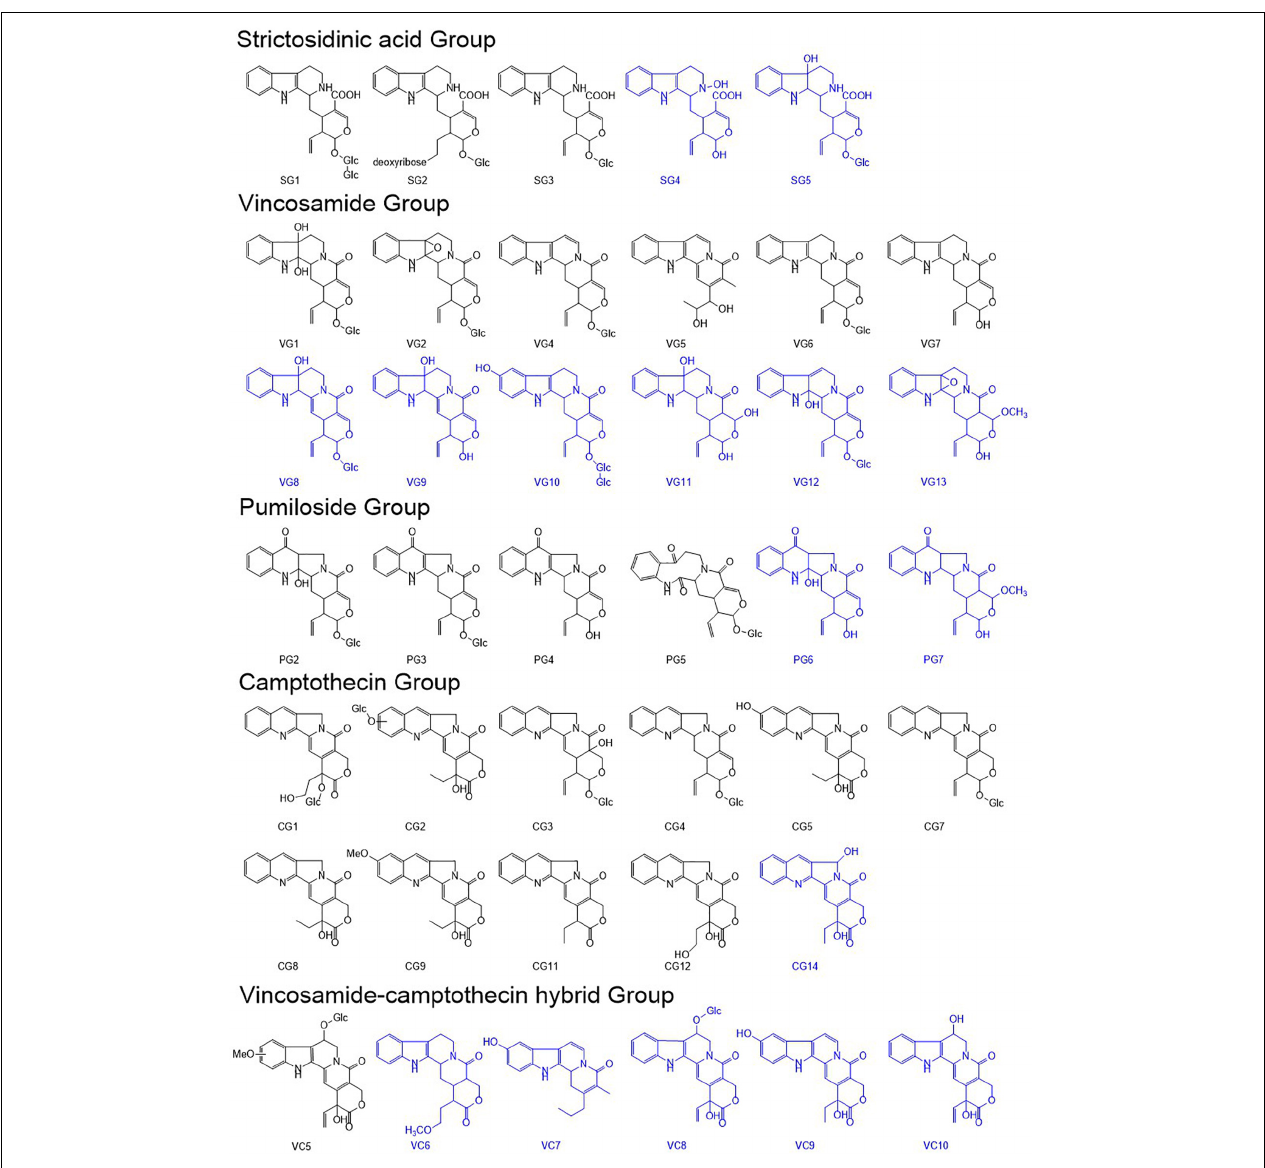
FIGURE 4 | The structures of the identified camptothecin (CPT) analogs and the downstream biosynthetic precursors. New alkaloids are marked in blue.